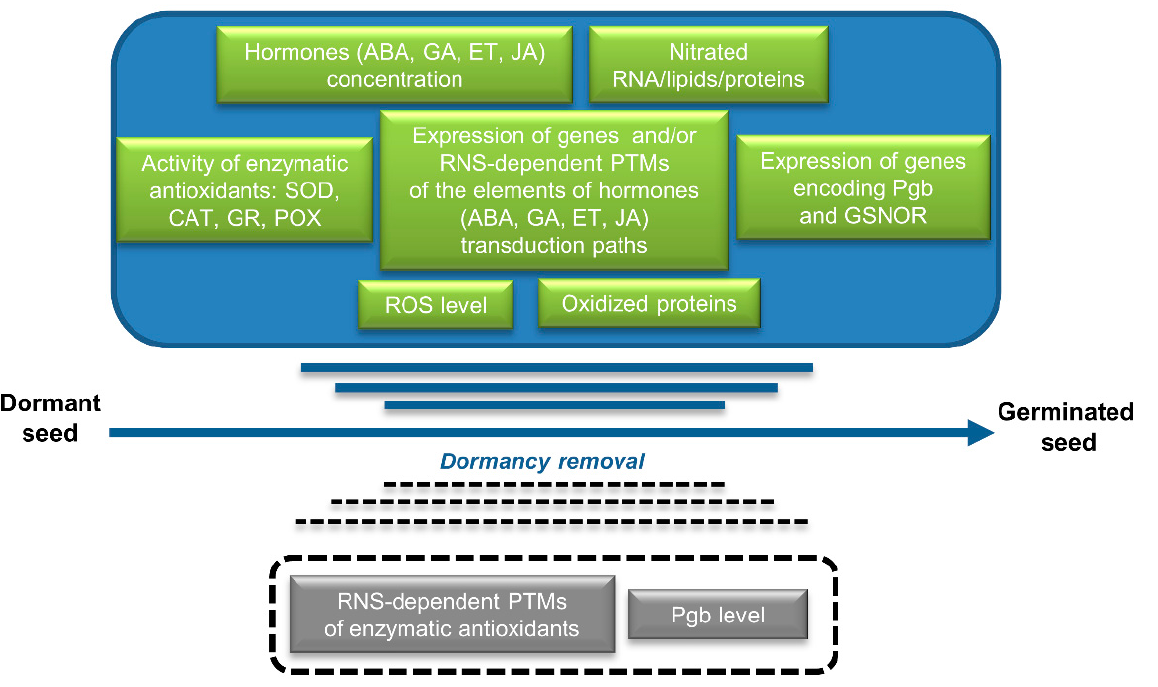
Figure 4. RNS (NO)-induced changes leading to seed dormancy removal and stimulation of seed germination. The order of changes marked in the figure does not reflect the actual sequence of events . Predicted but unproven changes are indicated in boxes with dashed